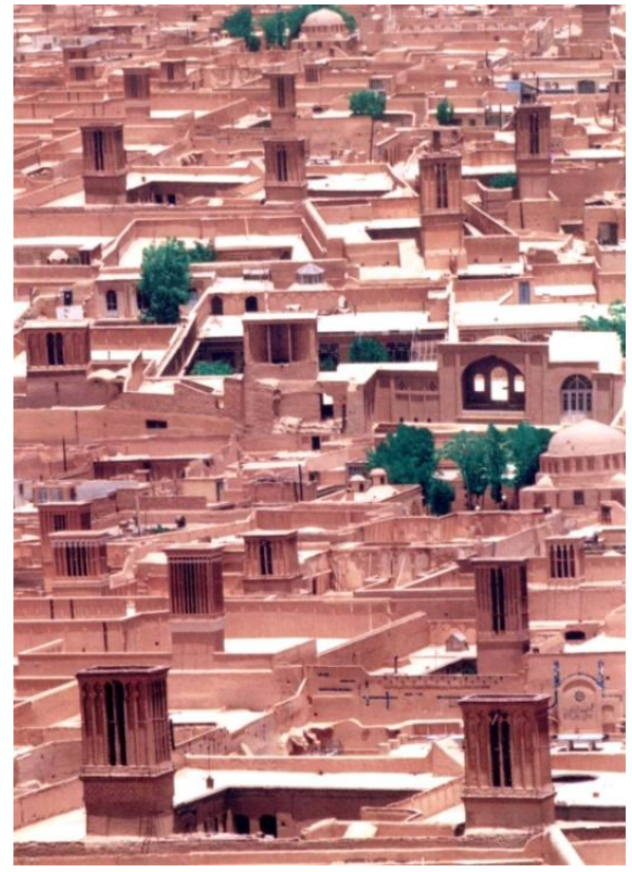
Figure 2. A view of conventional and traditional wind towers in Yazd city, Iran